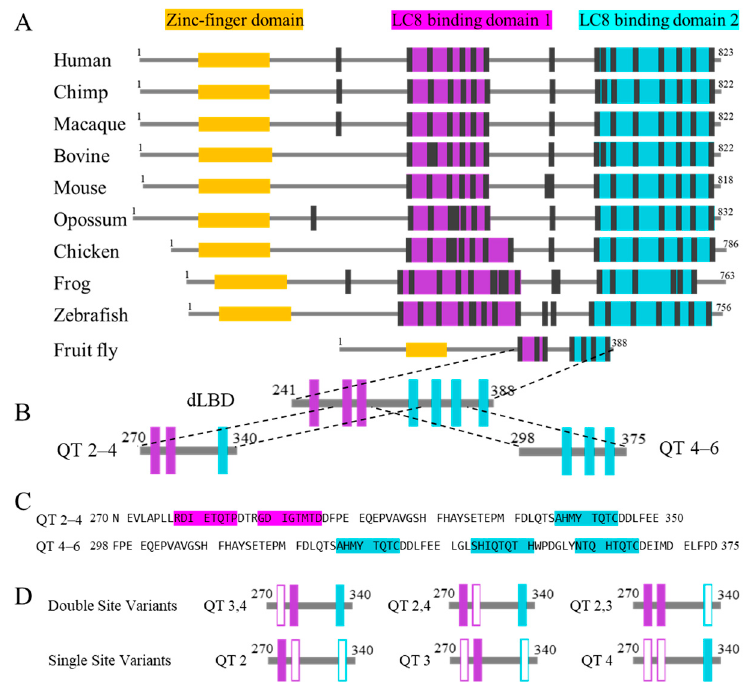
Figure 2. Alignment of ASCIZ homologs’ domain architecture and dASCIZ constructs. ( A ) Comparison of 10 ASCIZ homologs, aligned to show the similarity of the LBDs and the linker connecting LBD1 to LBD2. ( B ) Drosophila ASCIZ LC8 binding region and the constructs utilized in this study, including QT2–4 and QT4–6. ( C ) Sequences of QT2–4 and QT4–6. ( D ) Variants that systematically abolish either one ( top ) or two ( bottom ) LC8 recognition motifs from QT2–4 through mutation of the anchor triplet to AAA. Hollow boxes indicate sites that have been mutated. Construct nomenclature denotes the binding sites left intact in each construct.